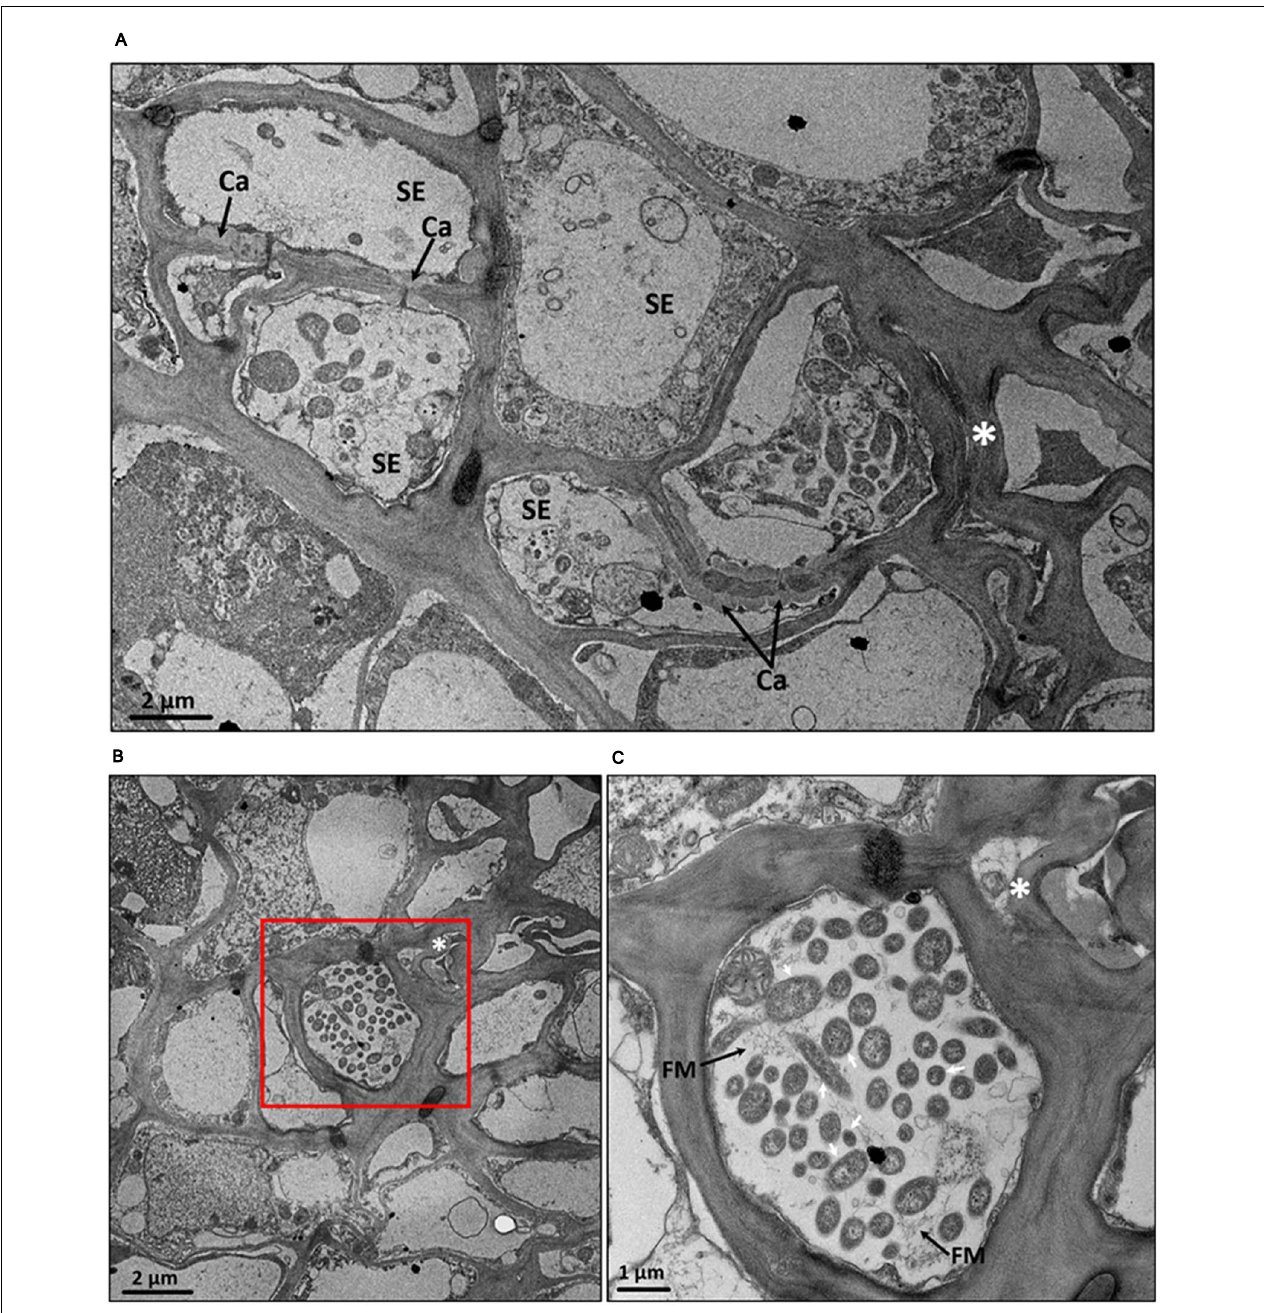
FIGURE 8 | Transmission electron micrographs of cross section of fruit pith tissues from “ Candidatus Liberibacter asiaticus”–infected “Shatangju” mandarin. (A) Collapsed phloem cells and callose deposition in the plasmodesmata pore between sieve elements of CLas-infected fruit pith. (B) A high abundance of CLas cells with elongated and round forms in the phloem cell. (C) The close-up of red region in panel (B) . SE, sieve element; Ca, callose; FM, filamentous material found around CLas cells. *Phloem cells collapse. Note double cell walls (white arrows) characteristic of Gram-negative bacterium, which is presumed to be CLas